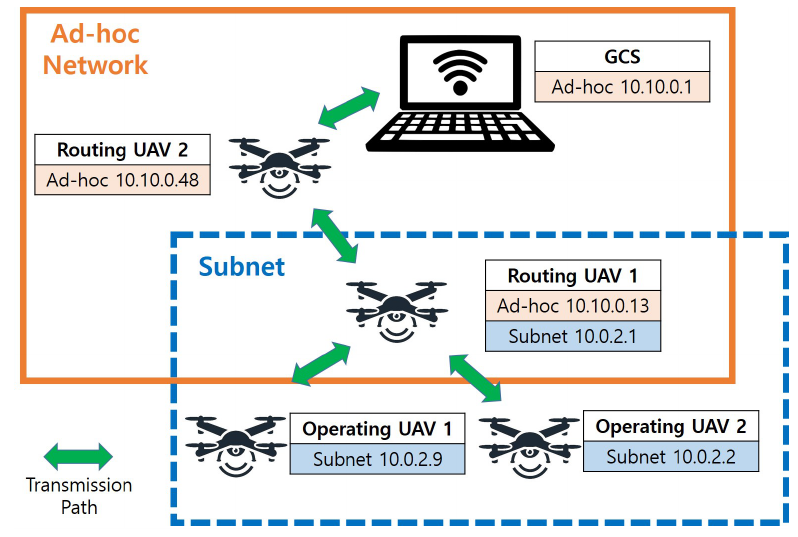
Figure 4. Network topology for